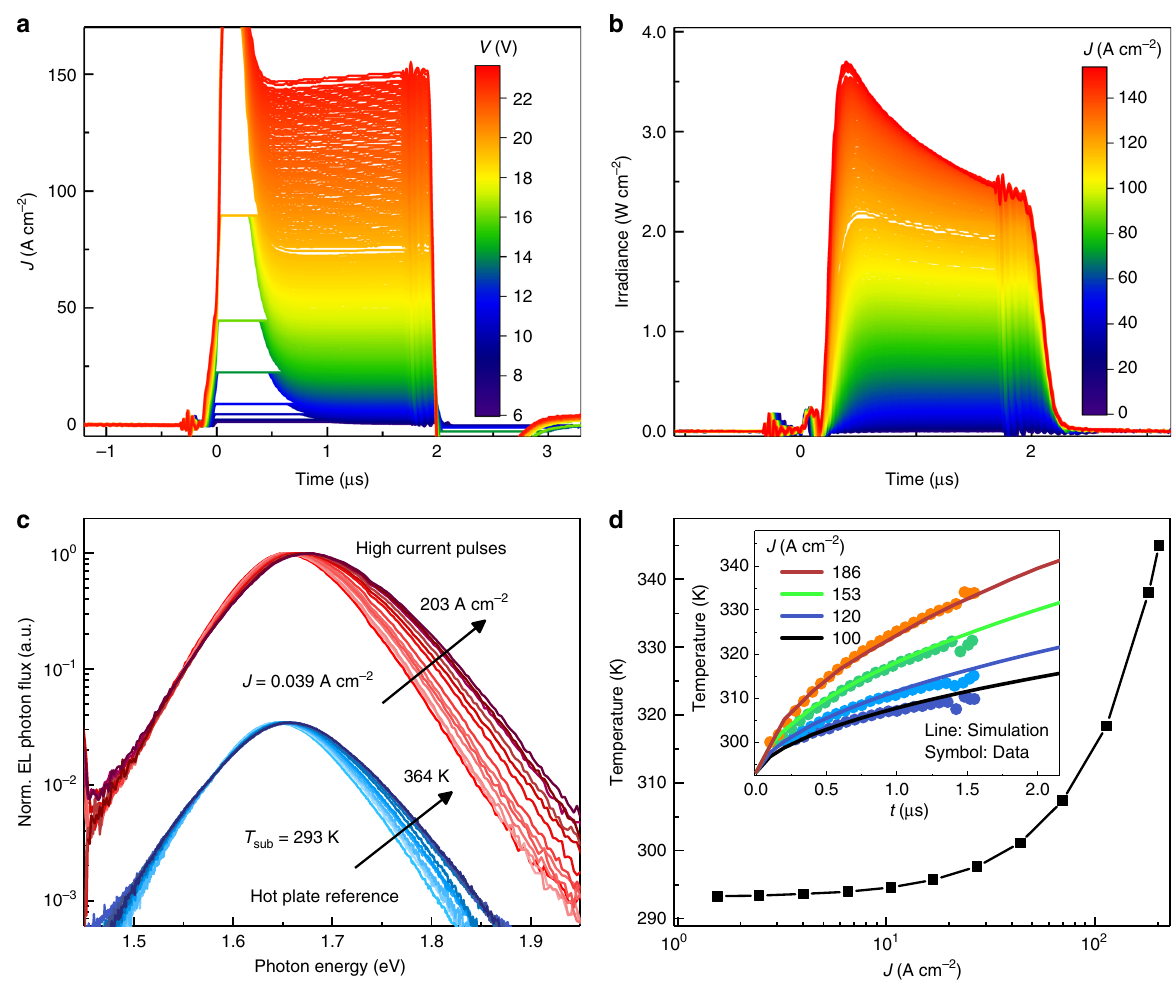
Fig. 6 Joule heating at high current density. Transient a current density and b irradiance at different pulsed voltages. The gradual increase in current and decrease in EL during the higher voltage pulses is suggestive of Joule heating. c The EL spectra recorded from the same pulses (upper red data set) demonstrates a peak shift and high energy broadening that are similar to a device operated at low current ( J = 0.001 A cm − 2 DC) while being heated on a hot plate (lower blue data set). d Finite element simulation of the average temperature in the perovskite layer at the end of a 2 µ s pulse with varying current density. The inset shows the transient temperature rise simulated for several current densities (solid lines). The corresponding EL decays from b are overlaid (inverted and scaled by a single, constant factor) to highlight the connection between the